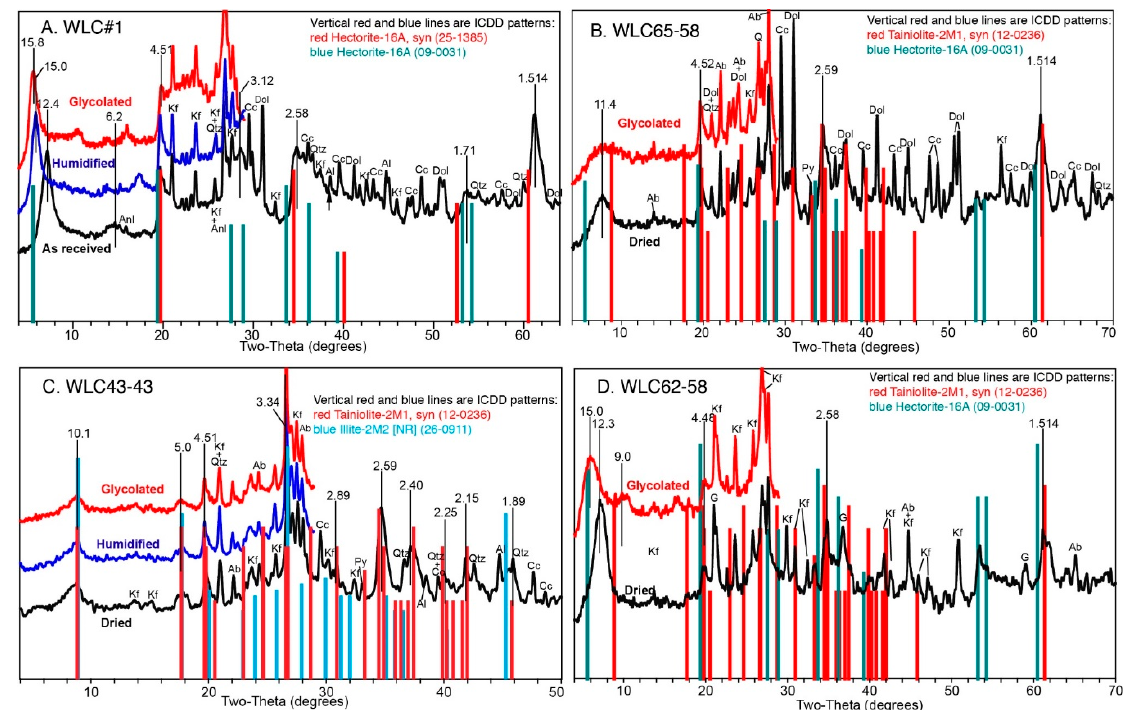
Figure 8. Thacker Pass XRD scans showing International Center for Diffraction Data (ICDD) mineral standards as colored vertical lines and d-spacing values (in angstroms) for peaks interpreted as clay peaks. In addition, major peaks for other minerals are albite (Ab), analcime (Anl), calcite (Cc), dolomite (Dol), goethite (G), K-feldspar (Kf), quartz (Qtz), and pyrite (Py). Where prominent, aluminum sample holder peaks labeled Al. ( A ) Pit sample of smectitic claystone with 2250 ppm Li from the Hectatone pit (see Figure 3A). ( B ) Transitional zone claystone with 2860 ppm Li, from about 58 m depth in hole WLC65. ( C ) Illitic claystone with 6920 ppm Li from 43 m depth in hole WLC43. ( D ) Lower transitional claystone with 1230 ppm Li from 58 m depth in hole WLC62.